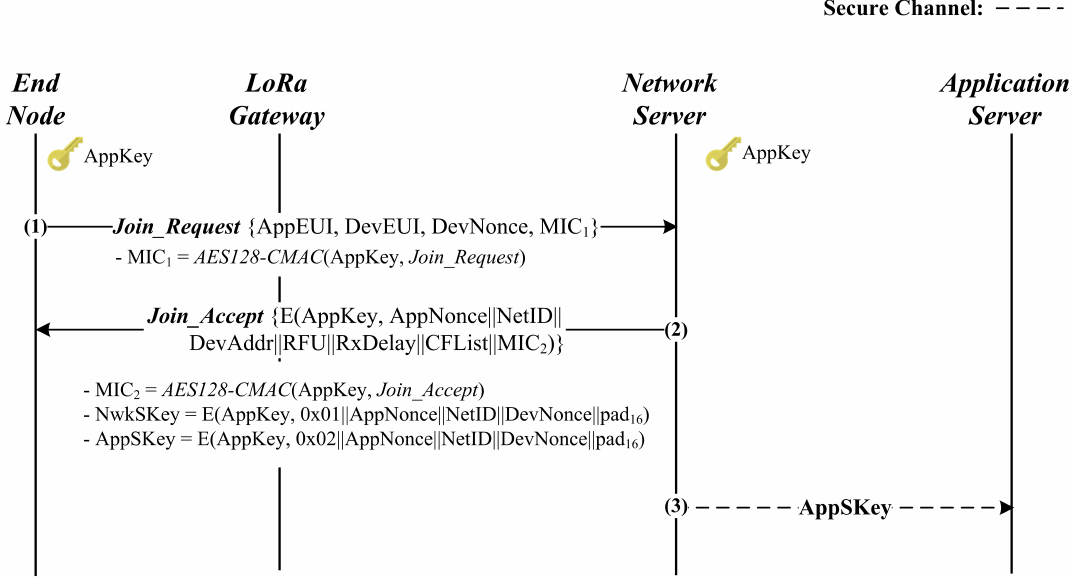
Figure 2. LoRaWAN Join